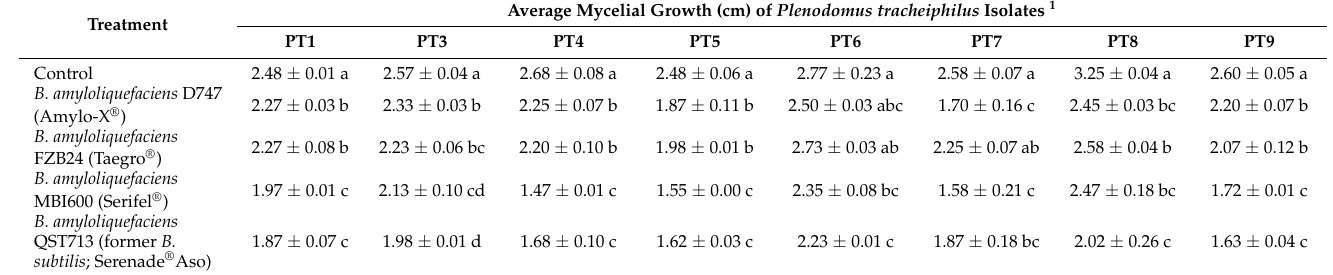
Table 2. In vitro effects of selected antagonistic bacterial filtrates in terms of reducing mycelial diameter in eight representative Plenodomus tracheiphilus isolates.